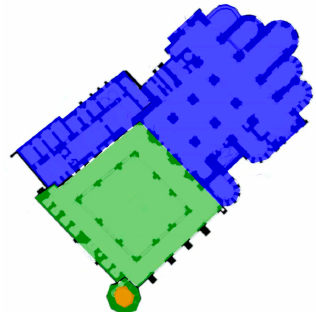
Figure 2. Construction phases: the blue represents the 13th century; the green represents the 14th century; and orange is the 15th century